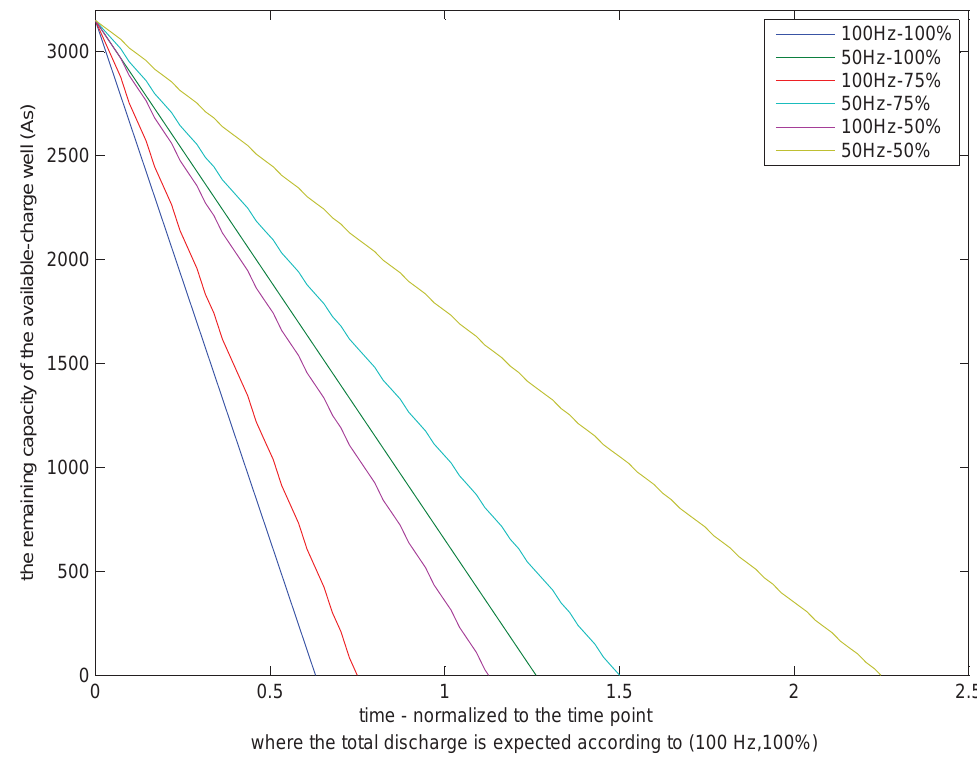
The KiBaM discharge model where C = 1400 mAh = 5040 As, c = 0 . 625 , k = 4 . 5 E − 5 /s , p = 0 . 1 , λ = 2 f = { 50 , 100 } Hz, r = n ∆ t , n = { 1 / 2 , 3 / 4 , 1 } , f s s